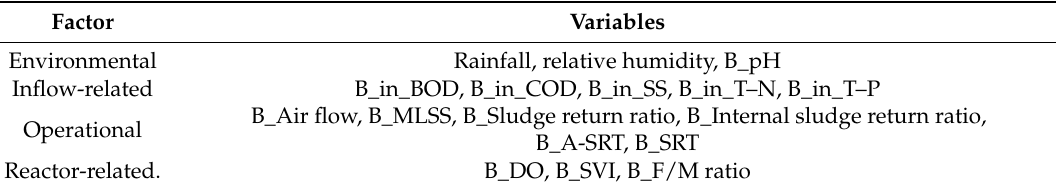
Table 9. Latent variables deduced by factor analysis for effluent T–P